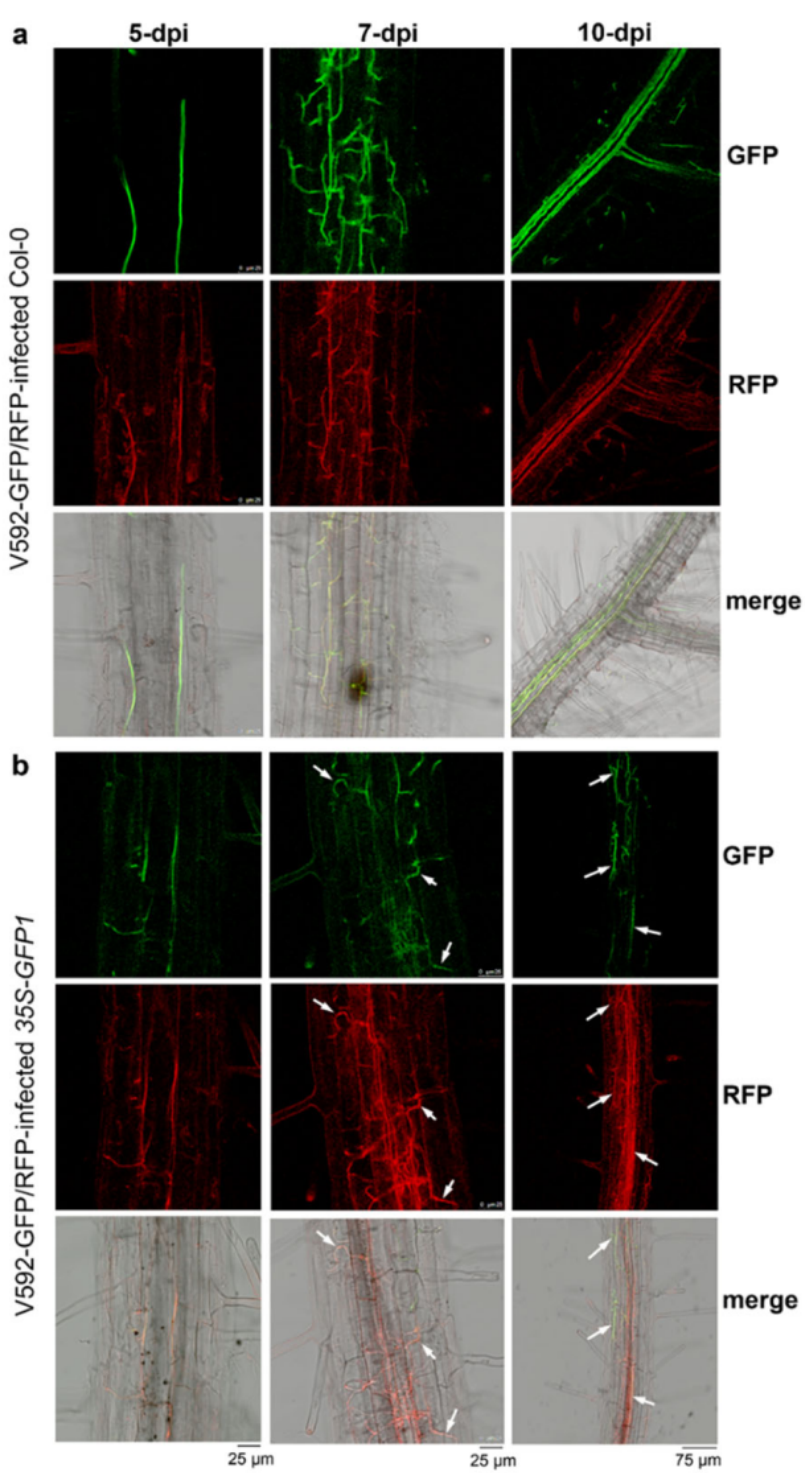
Figure 4. Confocal laser scanning microscopy observation of GFP silencing in V. dahliae within infected Arabidopsis roots. ( a , b ) Confocal laser scanning microscopy images of GFP and RFP signals in hyphae within wild-type ( Col-0 ) ( a ) and 35S-GFPi transgenic ( b ) Arabidopsis roots infected by double-labeled V. dahliae isolate V592-GFP/RFP. The merged images are compound micrographs of bright field transmission and the corresponding GFP and RFP fluorescence images. Examples of hyphae overlapped with both GFP and RFP signals are indicated by arrows. Six images for each root sample were observed and similar results were